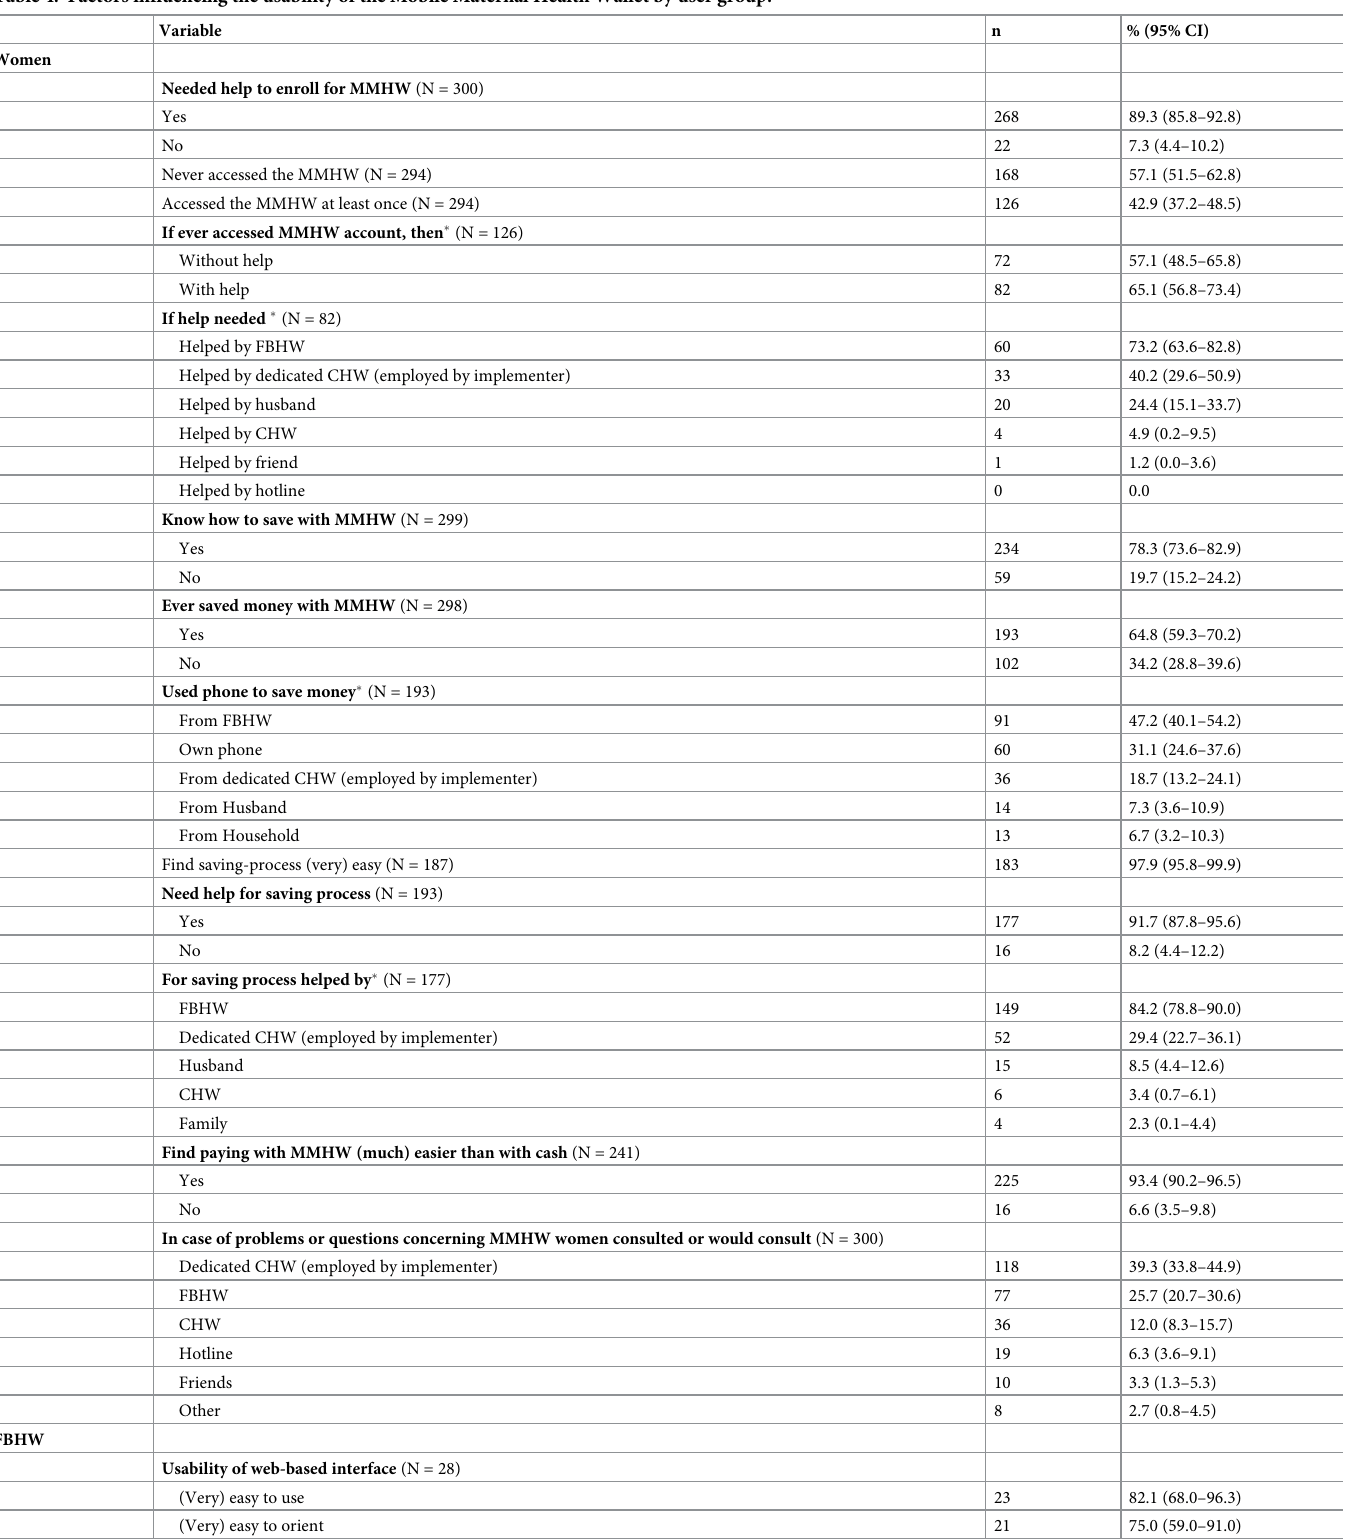
Table 4. Factors influencing the usability of the Mobile Maternal Health Wallet by user